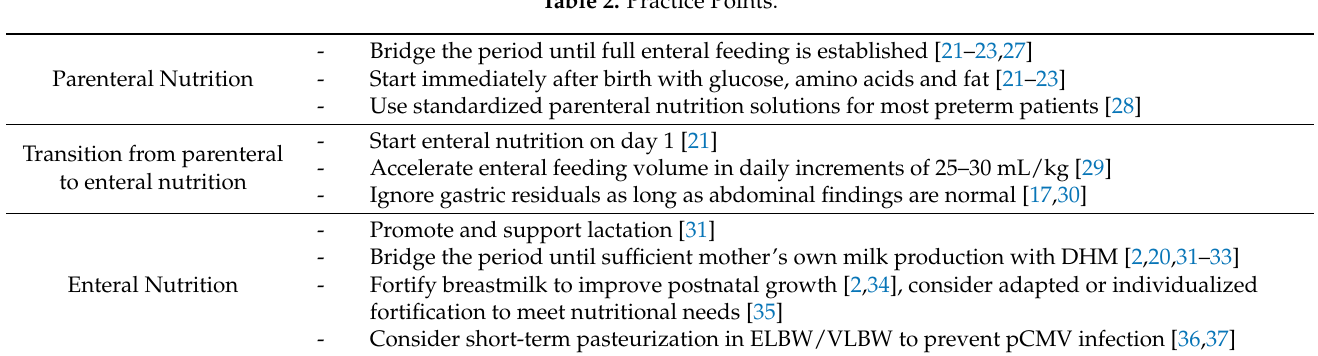
Table 2. Practice